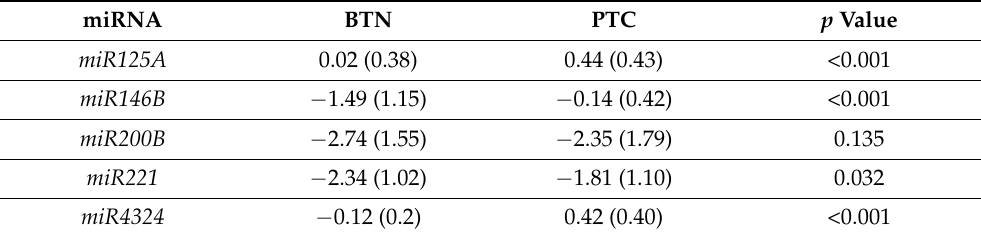
Table 4. Comparison of miRNA relative expression between BTN and PTC groups. miRNA BTN PTC p Value miR125A 0.02 (0.38) 0.44 (0.43) <0.001 miR146B − 1.49 (1.15) − 0.14 (0.42) <0.001 miR200B − 2.74 (1.55) − 2.35 (1.79) 0.135 miR221 − 2.34 (1.02) − 1.81 (1.10) 0.032 miR4324 − 0.12 (0.2) 0.42 (0.40) <0.001